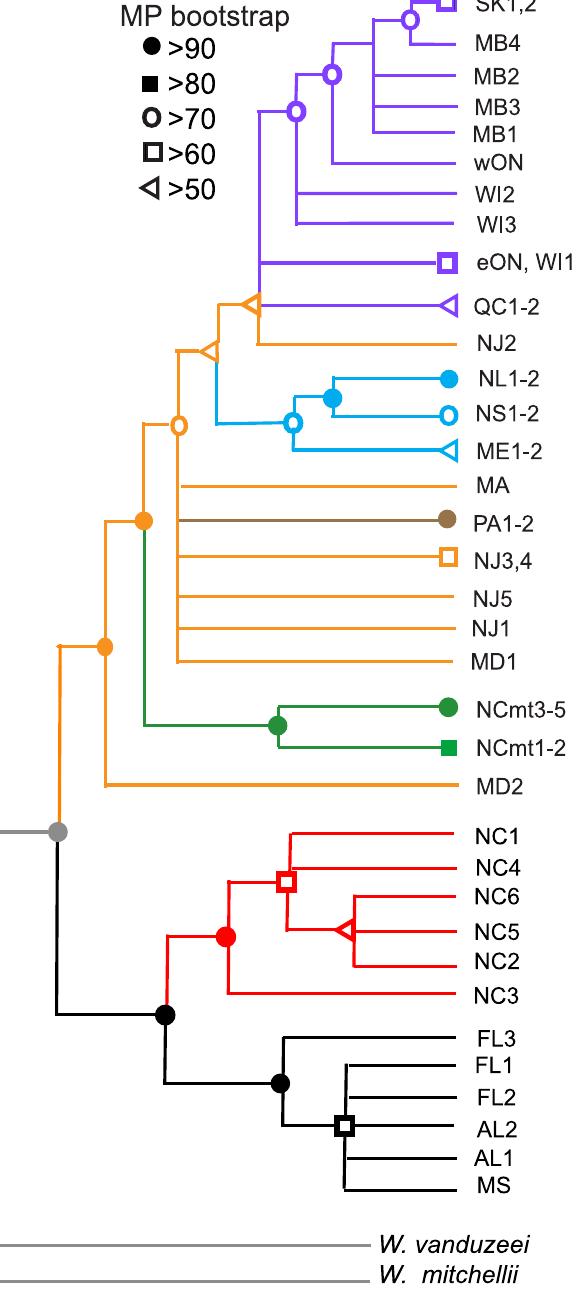
Figure 3. Maximum parsimony with bootstrap support for the combined 46 populations. The tree is based on 54 bp reads. Symbolic bootstrap support values are shown for each node with . 50% support. Color codes are the same as in Figures 1–2. There are two major monophyletic groupings: one consisting of populations along the Gulf and North Carolina Coasts, the other consisting of all more northern and mountain populations. The mainland Maryland population (MD2) shares a most recent common ancestor with all more northern and mountain populations. Phylogenetic results generally follow latitude except for the mountain populations (NCmt, PA). There are six well supported clades (bootstrap . 70) that include two or more populations: Gulf Coast (MS, AL, FL: black), North Carolina Coast (NC: red), North Carolina mountains (NCmt: green), Pocono Mountains (PA: brown), northeast (ME, NS, NL: blue), and northwest (WI2–3, wON, MB, SK: purple). The North Carolina mountain populations (NCmt) split